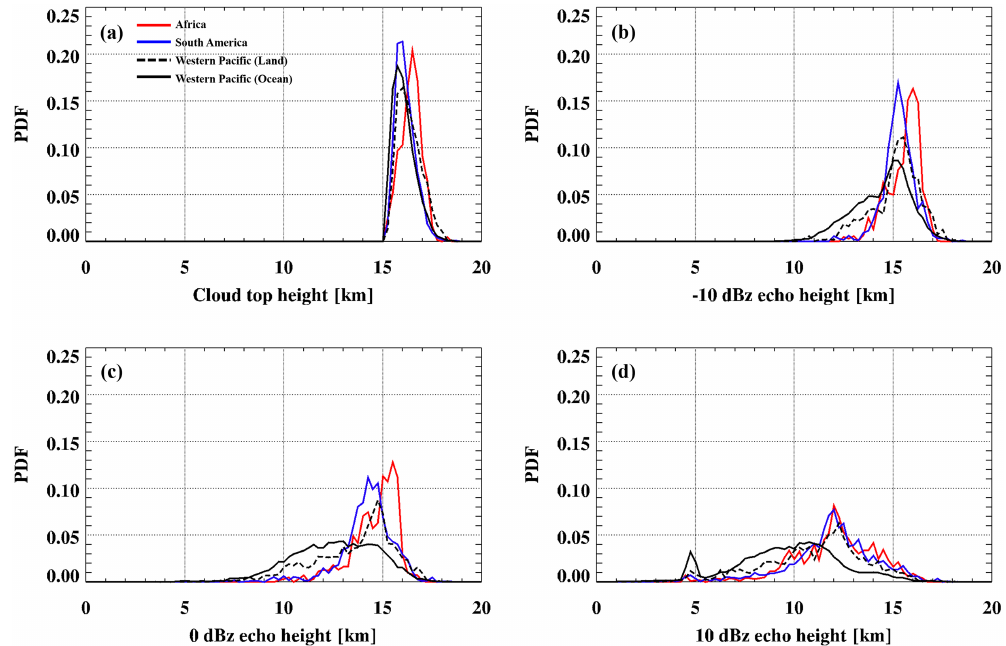
Figure 5. PDF distributions of (a) cloud top height; echo top height showing (b) − 10, (c) 0, and (d) 10dBZ in DCC samples.